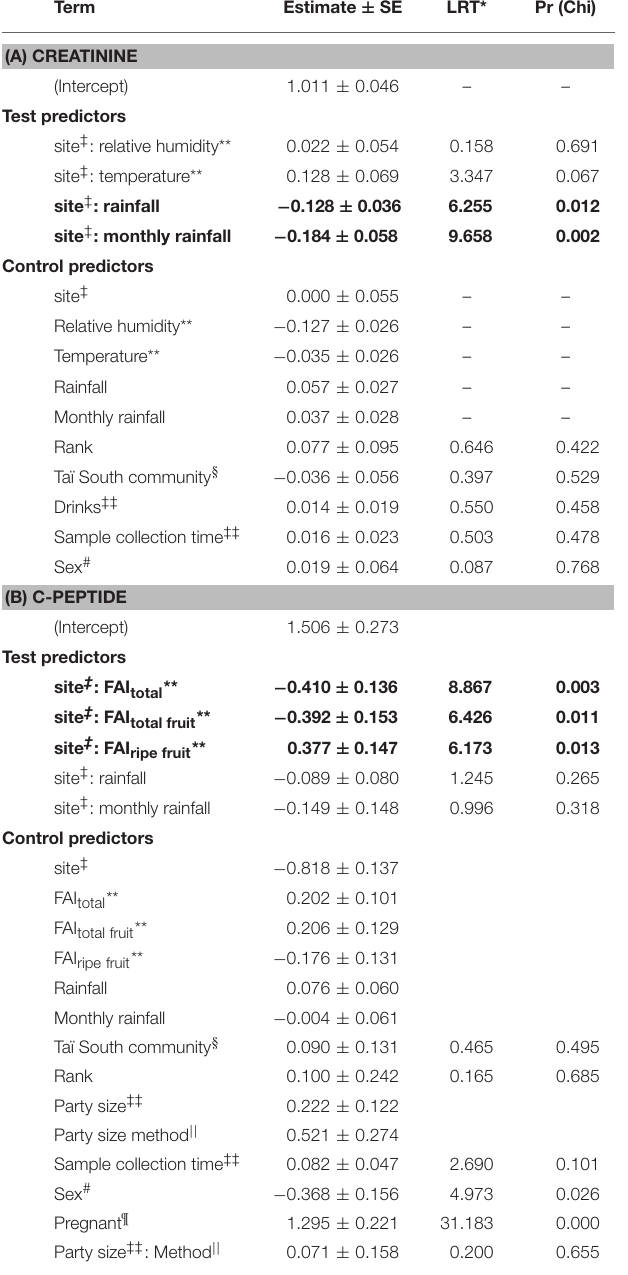
TABLE 3 | Model results for inter-site differences of environmental variables on urinary biomarkers at Fongoli and Taï. Term